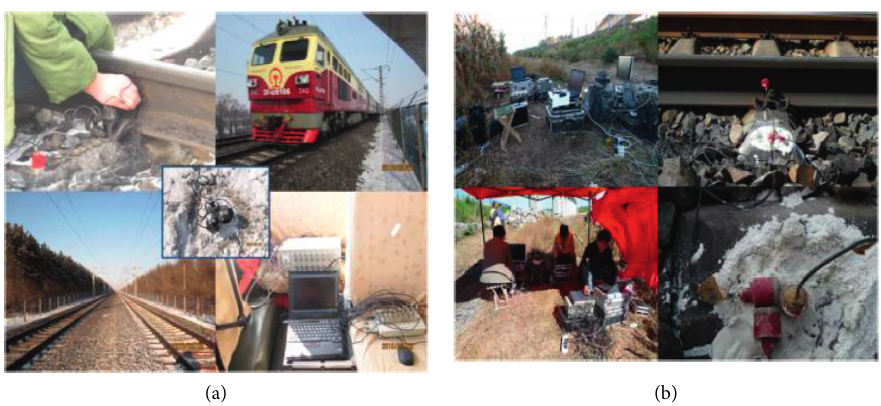
Figure 1: General conditions of field monitoring: (a) frozen period; (b) unfrozen period.